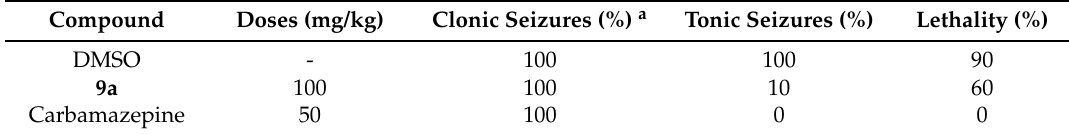
Table 3. Effect of compound 9a on scPTZ-induced seizures in mice (i.p.). Compound